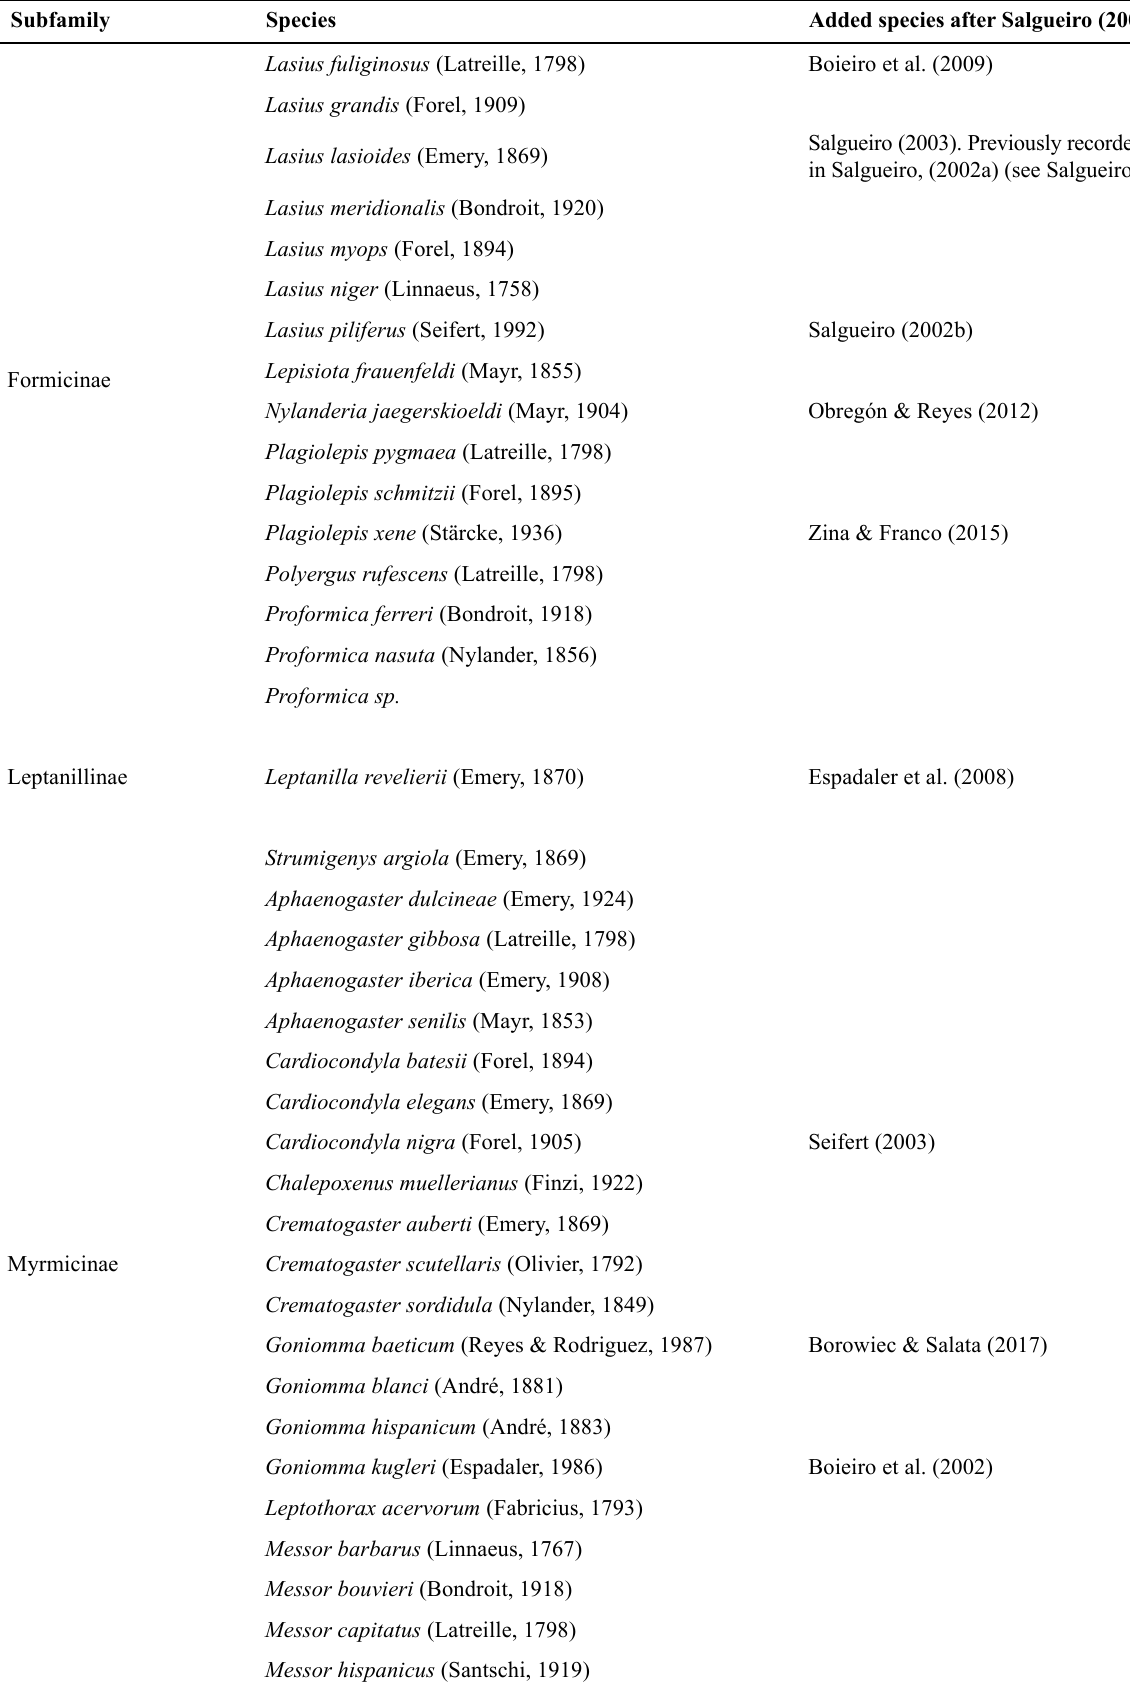
Table 3 . Complete checklist of continental Portuguese ant fauna, combining that of Salgueiro (2002a) and posterior additions. Nomenclatural changes proposed after 2002 have been applied to the names. (Continuation) Subfamily Species Added species after Salgueiro